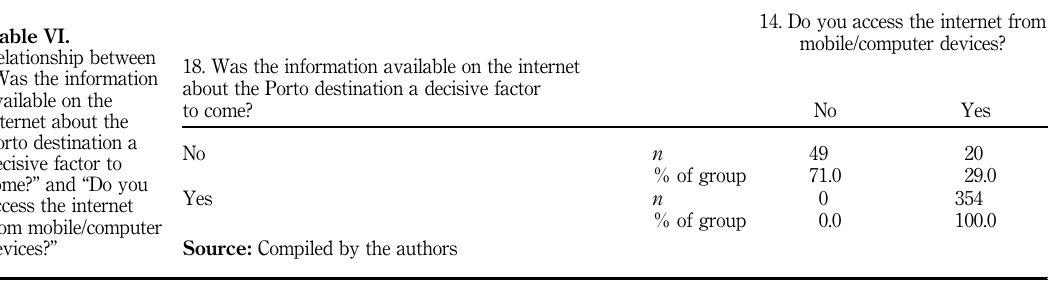
“ Was the information available on the internet about the Porto destination a decisive factor to come? ” and “ Do you think it is important to have access to the internet at the Porto destination ”